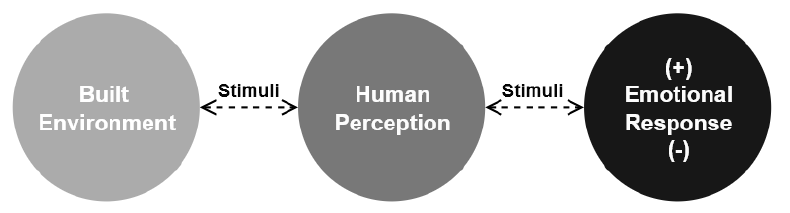
Figure 5. Human environmental interaction (illustration: author).